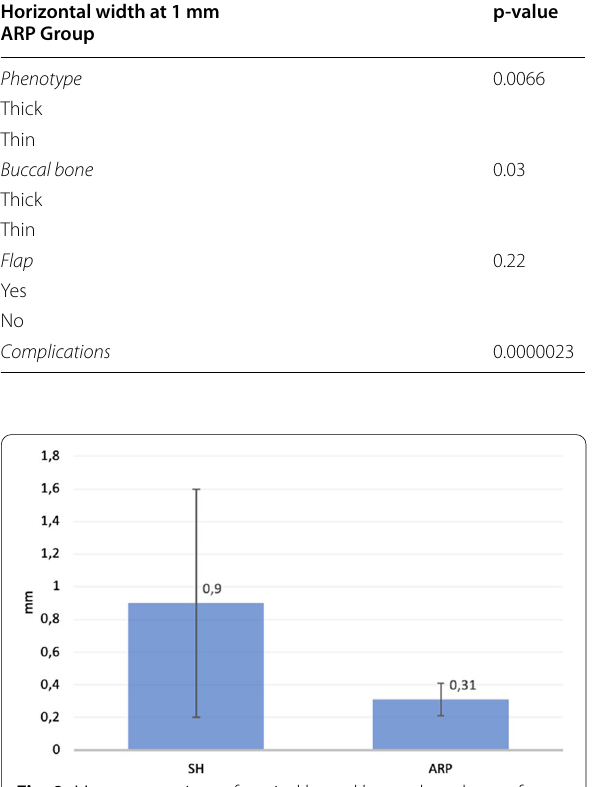
Fig. 9 Mean comparison of vertical buccal bone plate change